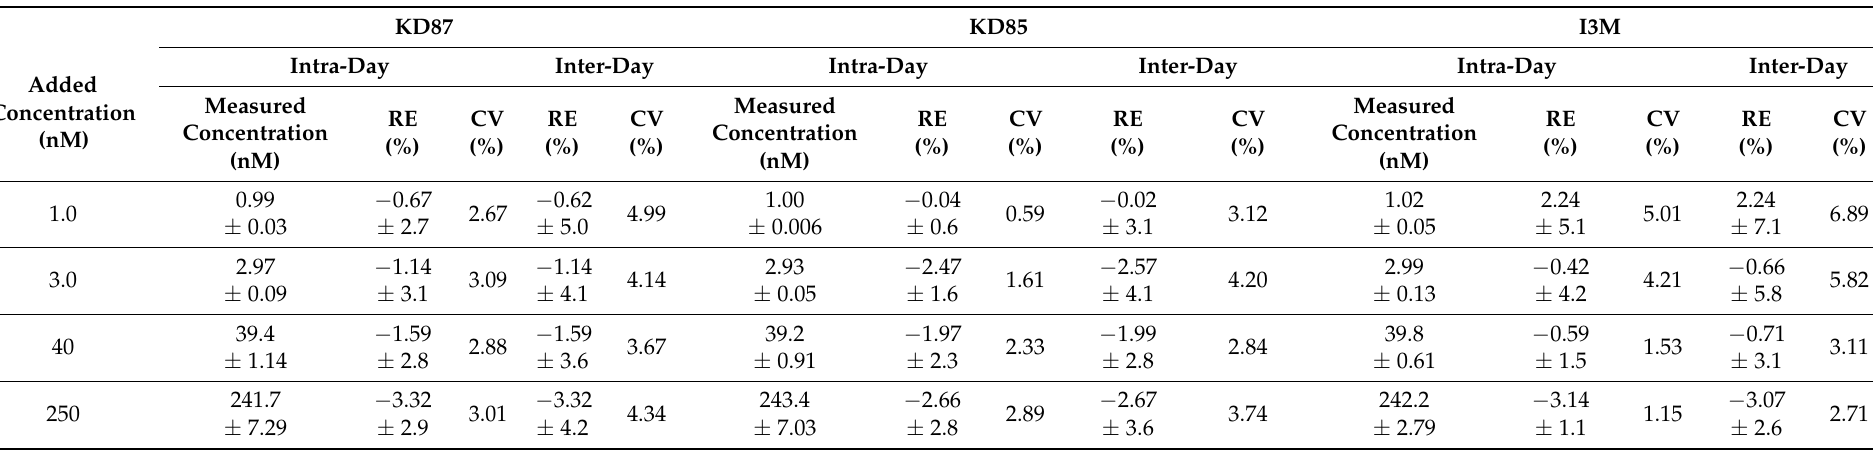
Table 3. Inter- and intra-day accuracy, expressed as relative error (RE) ± standard deviation (SD) and precision, determined as coefficient of variation (CV), of different samples each from four days of KD87, KD85, and I3M at LLOQ level (1 nM), low (3 nM), medium (40 nM), and high (250 nM) concentrations after extraction from plasma. The measured concentrations are given as mean values ± SD, n = 5–6 for intra-day, n = 20–24 for inter-day.